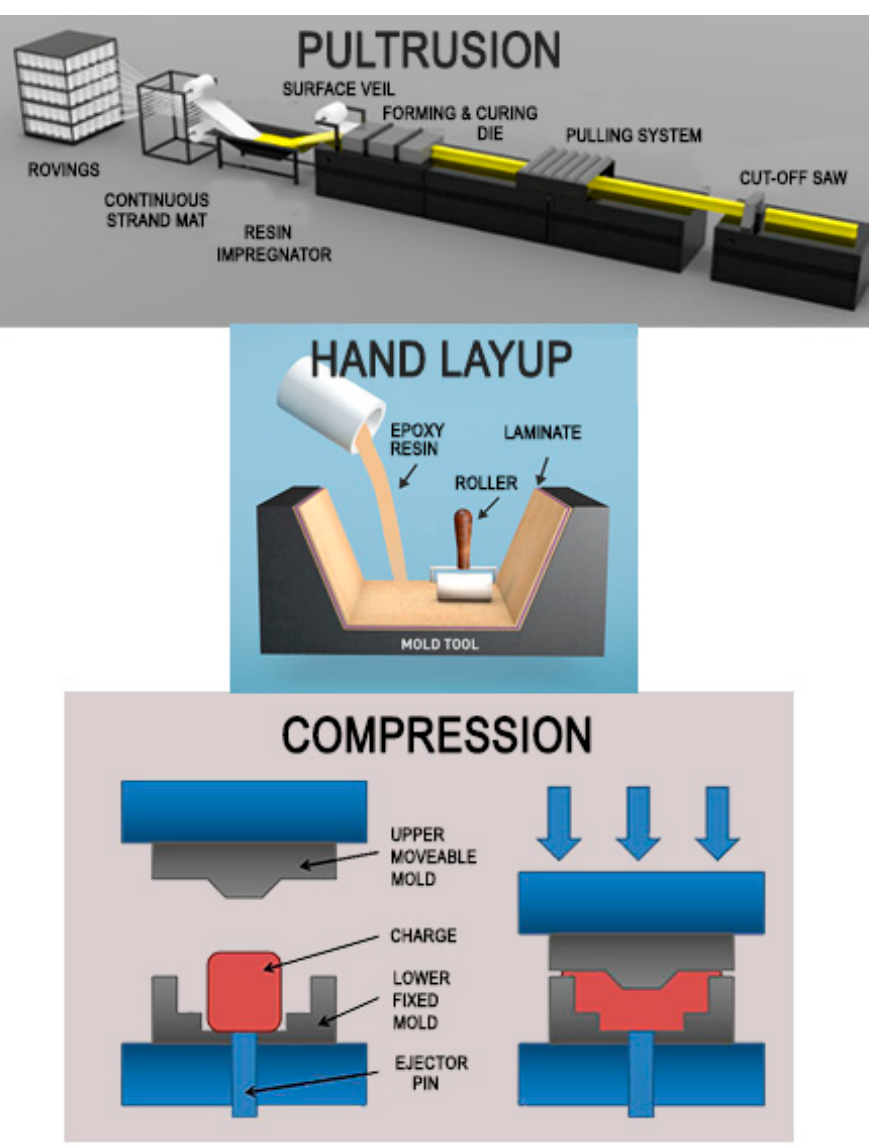
Figure 1. Various manufacturing processes of polymeric composite products.